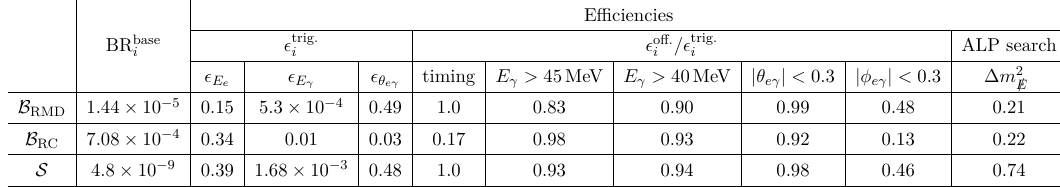
Table 2 . Efficiencies in each kinematic selection for the parasitic analysis (section 2.2). For signal, F V − A is fixed to 10 9 GeV. The “timing” selection refers to the tighter coincidence requirement in µe the offline cuts, as compared to the trigger selection. See section 2.1 for details.